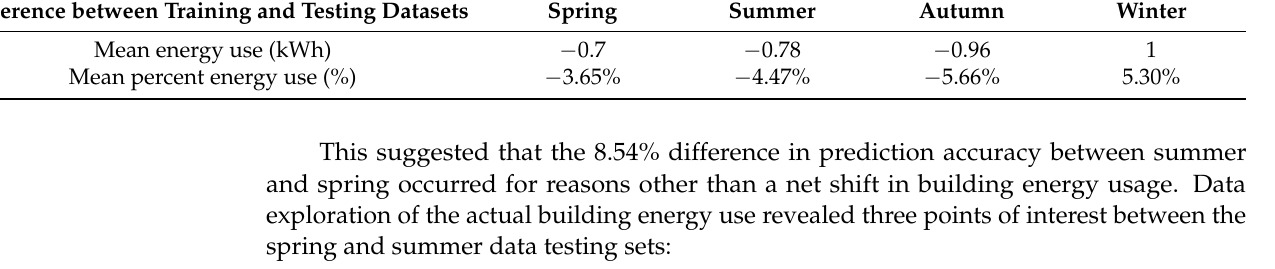
Table 1. The change in net energy use between training and testing datasets. Season Difference between Training and Testing Datasets Spring Summer Autumn Winter Mean energy use (kWh) − 0.7 − 0.78 − 0.96 1 Mean percent energy use (%) − 3.65% − 4.47% − 5.66%